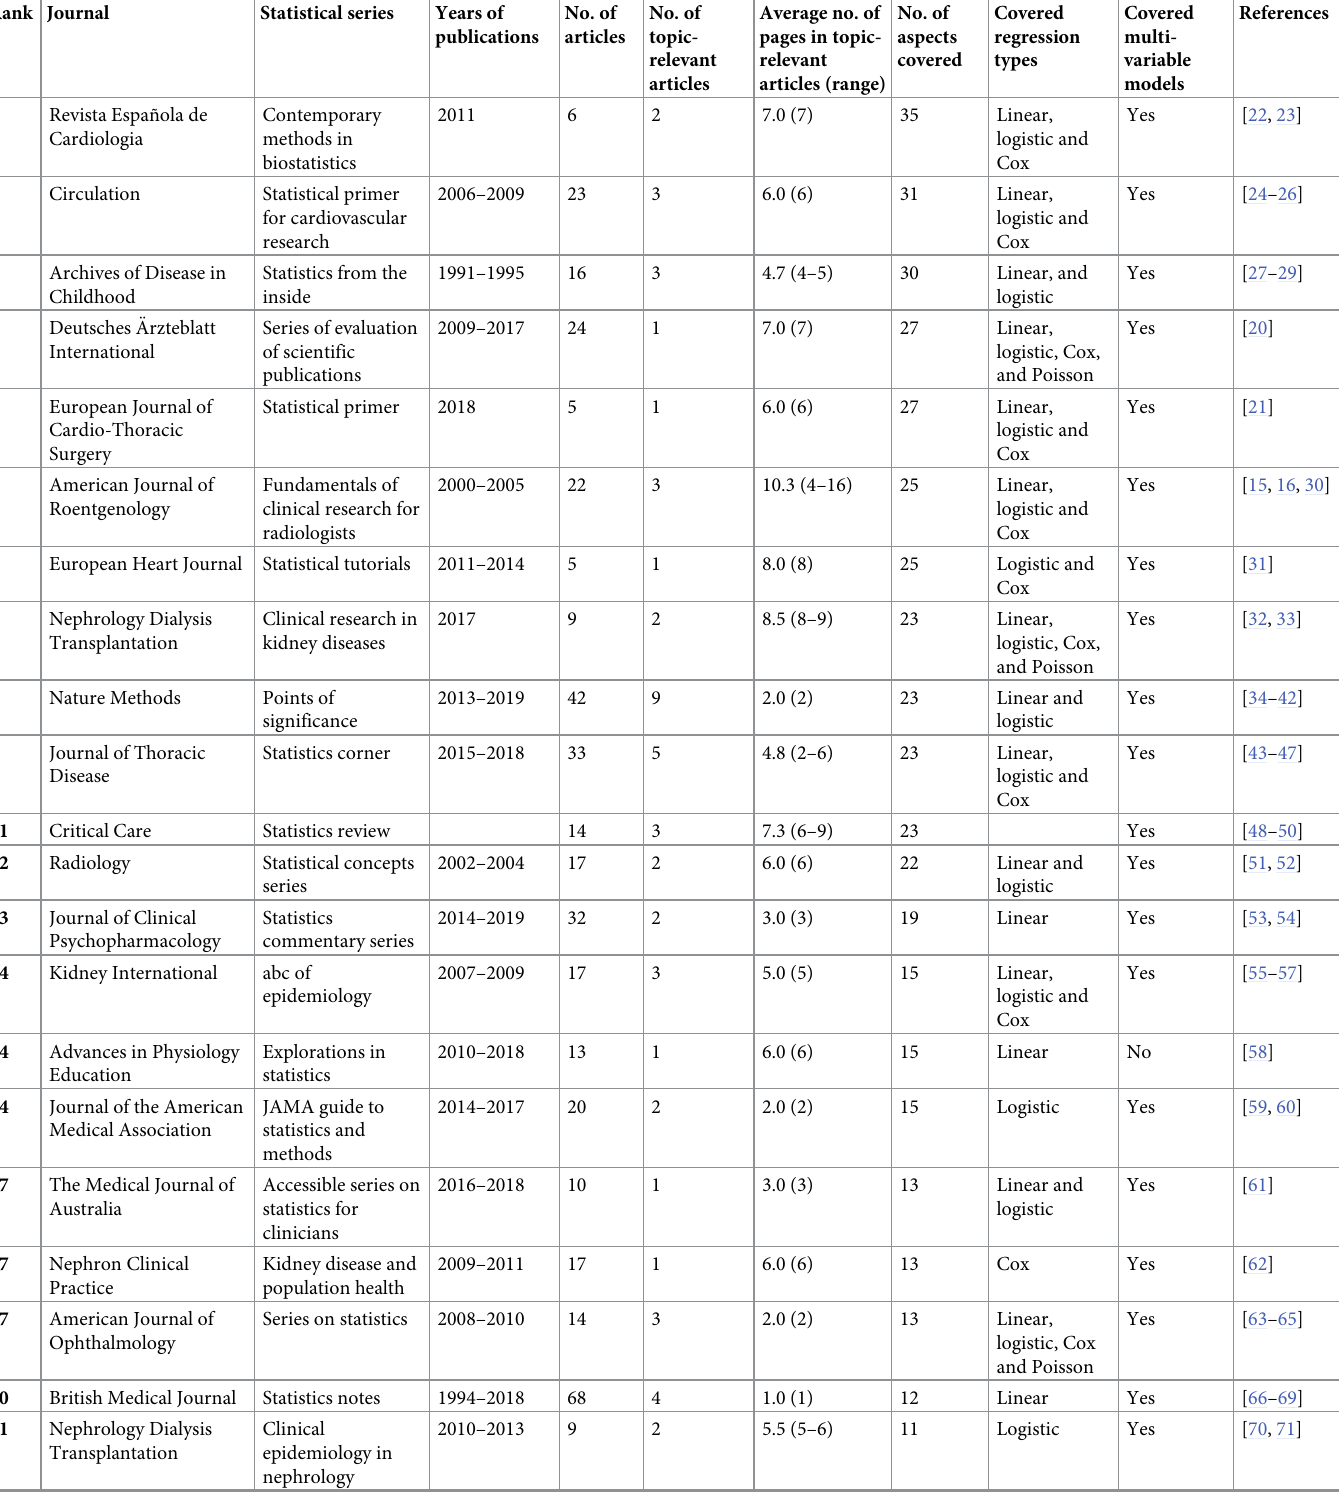
Table 1. Characteristics of included statistical series ranked by number of covered aspects. We considered 44 aspects, see S3